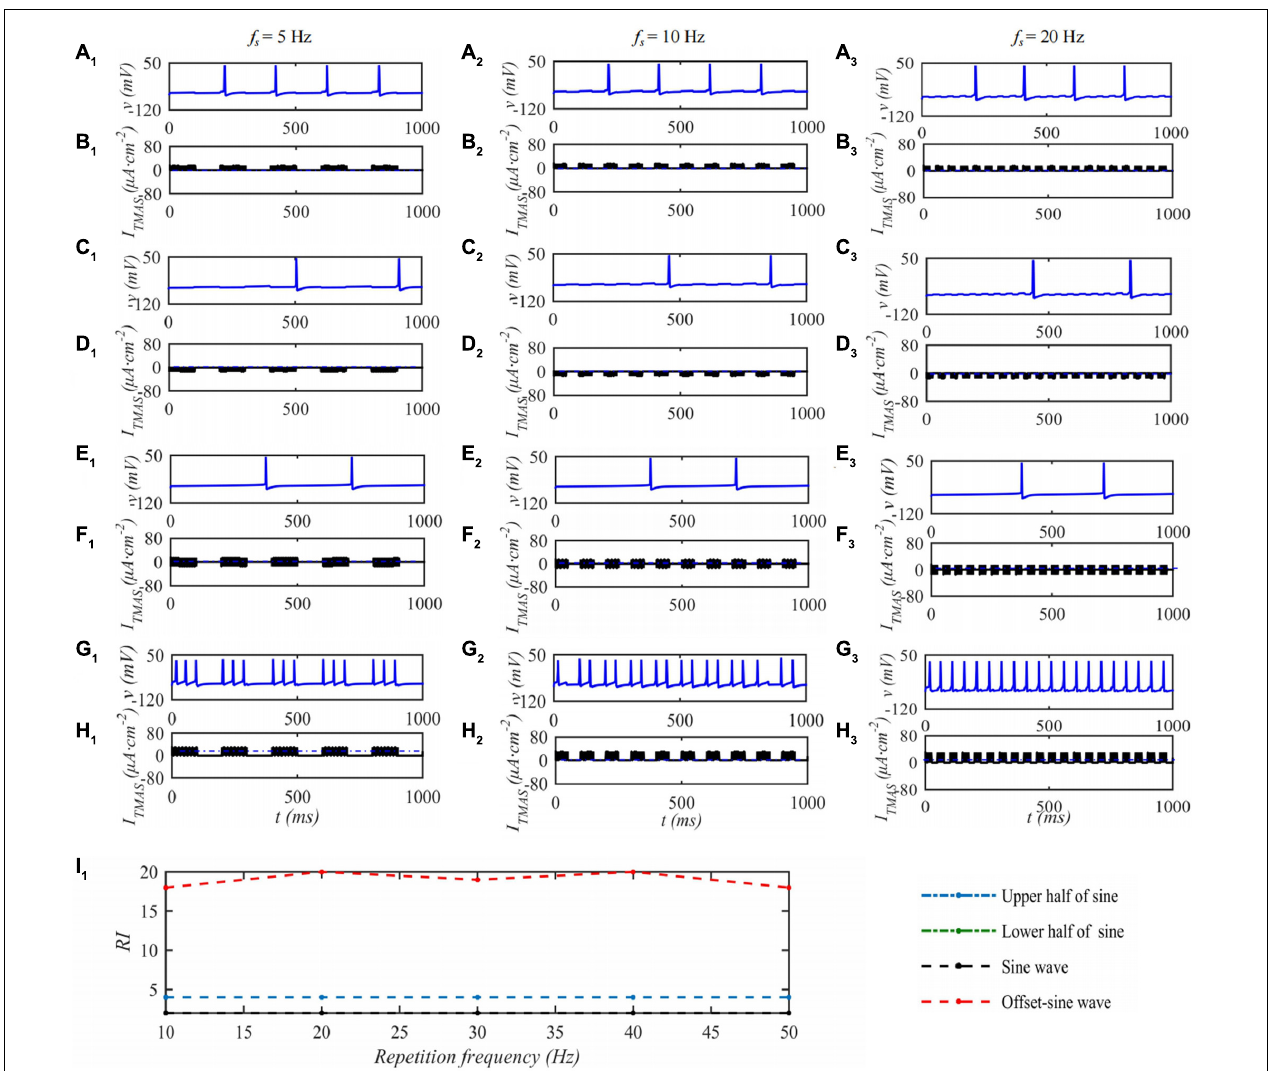
FIGURE 6 | The effect of TMAS repetition frequencies on a single STN discharge. Columns 1–3 ultrasonic pulse repetition frequencies f s = 5, 10 and 20 Hz, rows 1–4 are the upper, lower half sine wave, sine wave and offset sine wave stimulation, the blue and black curves are STN membrane potential and TMAS-induced current, (I 1 ) is the curve of STN neuron firing rate versus TMAS repetition frequency ( f = 0.5 MHz, I 0 = 0.1 W · cm - 2 , T 1 /T s = 50%, B = 0.3